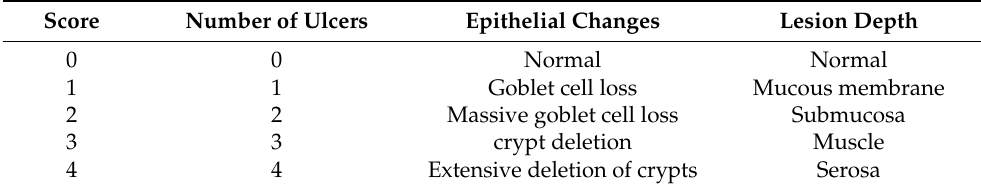
Table 2. Scoring criteria for histological